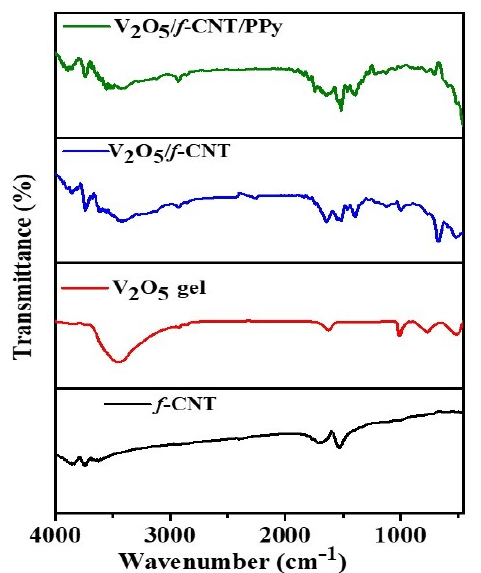
Figure 2. FTIR spectra of f -CNT, V 2 O 5 gel, V 2 O 5 / f -CNT, and V 2 O 5 / f -CNT/PPy.